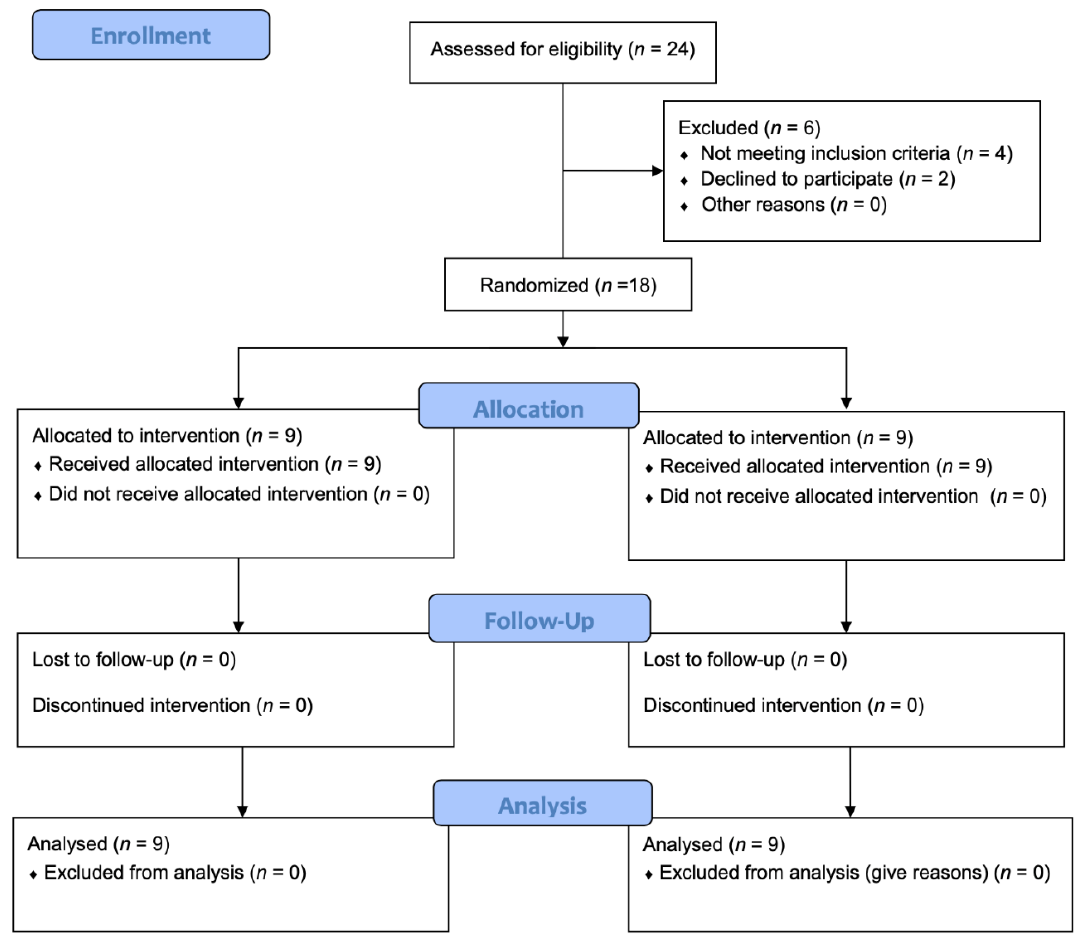
Figure 2. Consolidated Standards of Reporting Trials (CONSORT) flow diagram.